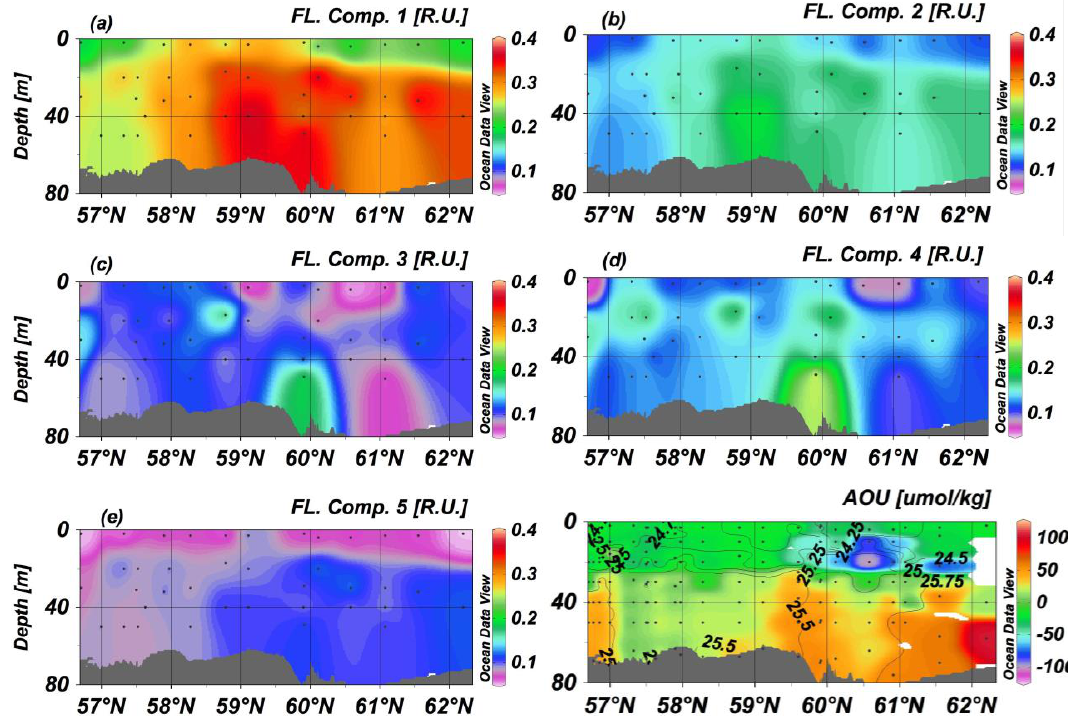
Figure 11. Vertical section of (a–e) fluorescence components C1–C5, and (f) AOU along the 70m